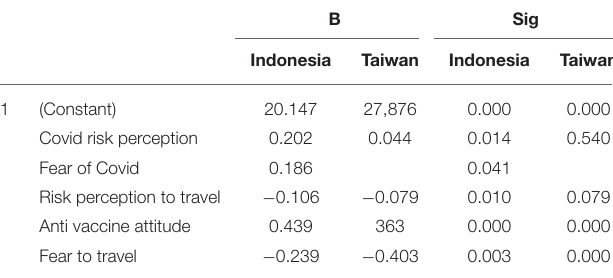
TABLE 3 | Two-country partial linearity test results.